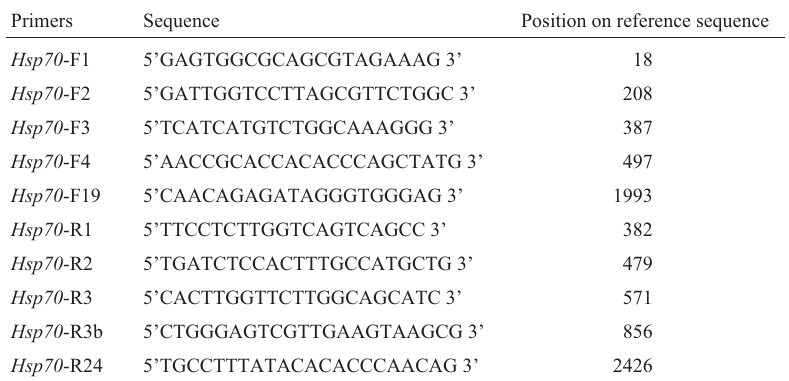
Table 1 - Primers used on PCR amplification of the chicken hsp70 gene.